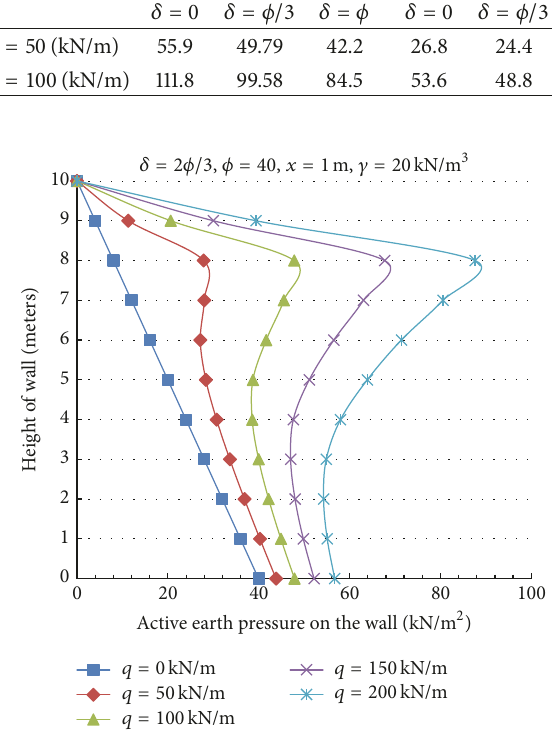
Figure 13: Resultant lateral earth pressure distribution for different values of line